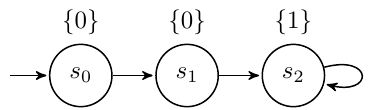
Figure 2. Kripke structure of the program P2